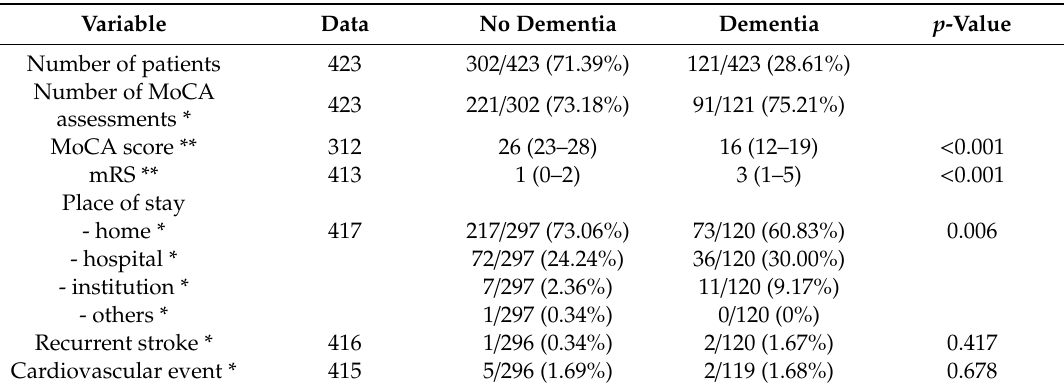
Table 1. Characteristics of the examined patients at the three-month